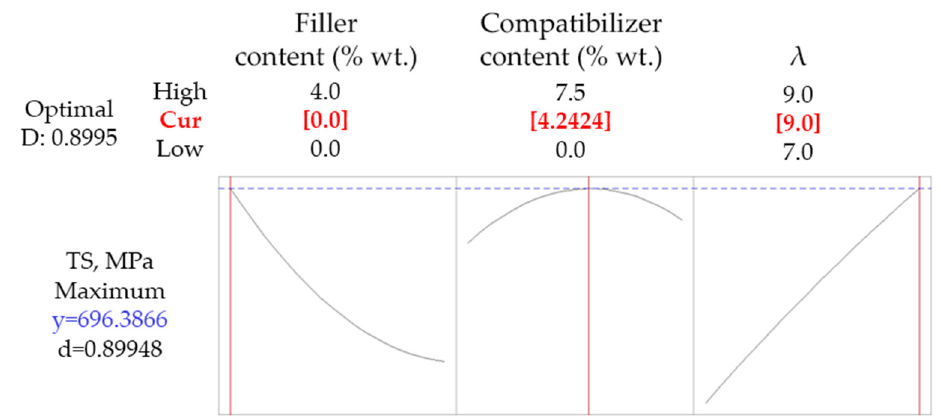
Figure 5. Optimization results targeting maximum TS for composites with talc.